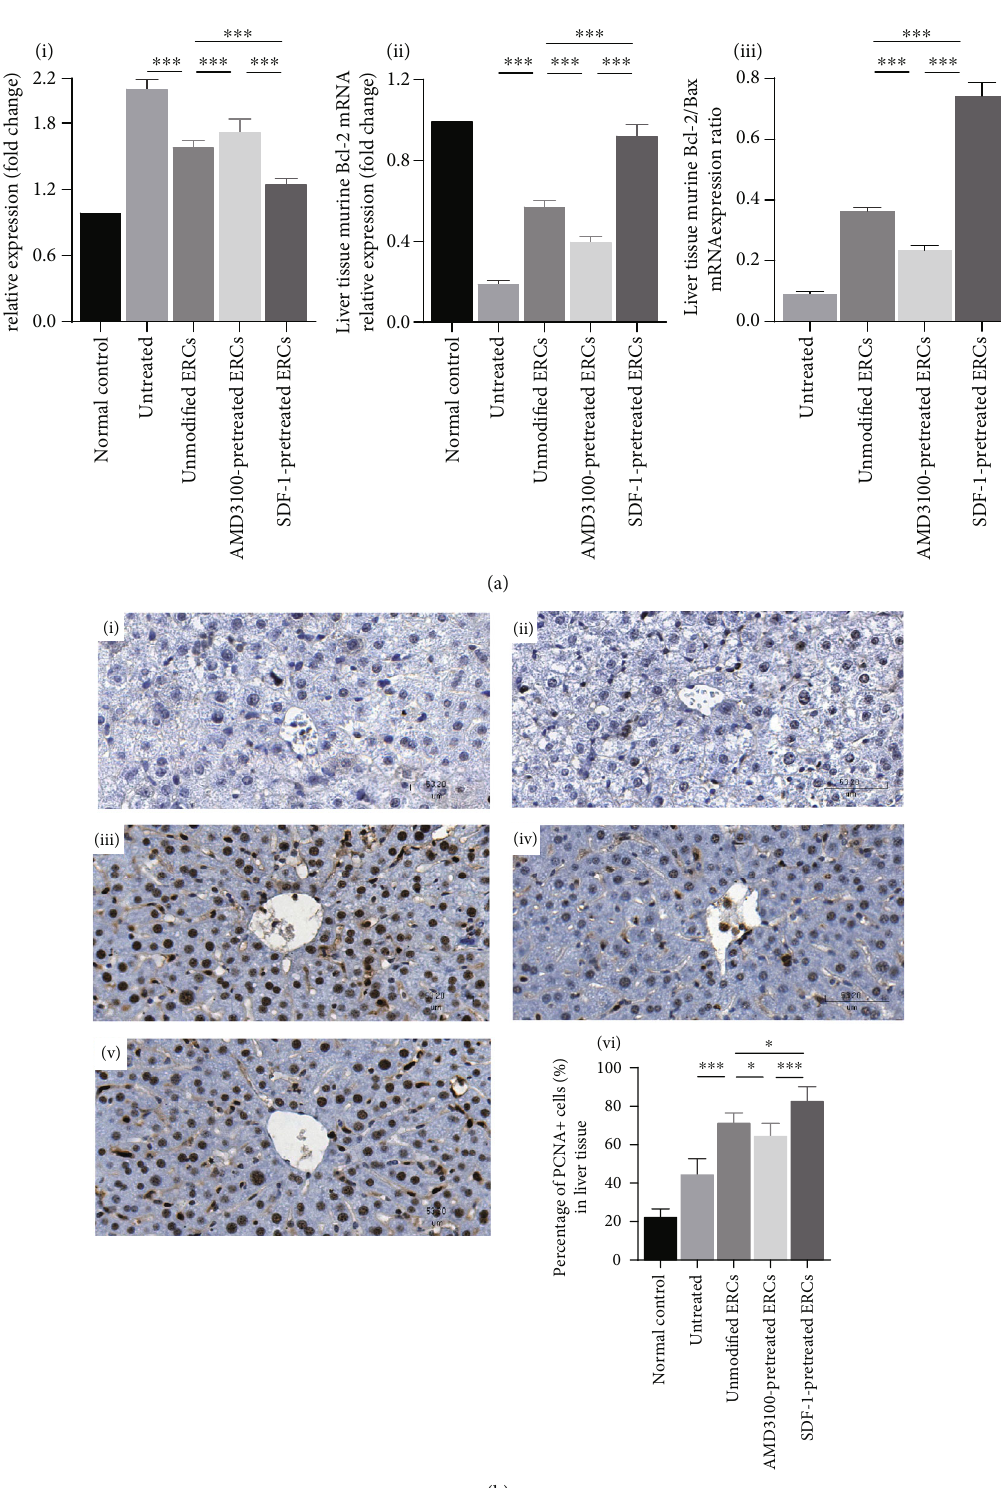
Figure 3: Pretreatment with SDF-1 on ERCs further ameliorated damages at molecular level in the process of sepsis. (a) The mRNA expression levels of murine Bax and Bcl-2 and Bcl-2/Bax mRNA expression ratio in liver tissue. (b) Immunohistochemical staining image of PCNA in the liver, (i) the normal control group, (ii) the untreated group, (iii) the unmodi fi ed ERC group, (iv) the AMD3100- pretreated ERC group, (v) the SDF-1-pretreated ERC group, and (vi) the percentage of PCNA-positive cells per high resolution fi eld (400x) in the liver. Statistical analysis was performed by one-way ANOVA followed by the LSD test, n = 6 . ∗ p < 0 : 05 , ∗∗ p < 0 : 01 , and ∗∗∗ p < 0 : 001 . Bar graphs represent mean ± SD . Abbreviation: ERCs: endometrial regenerative